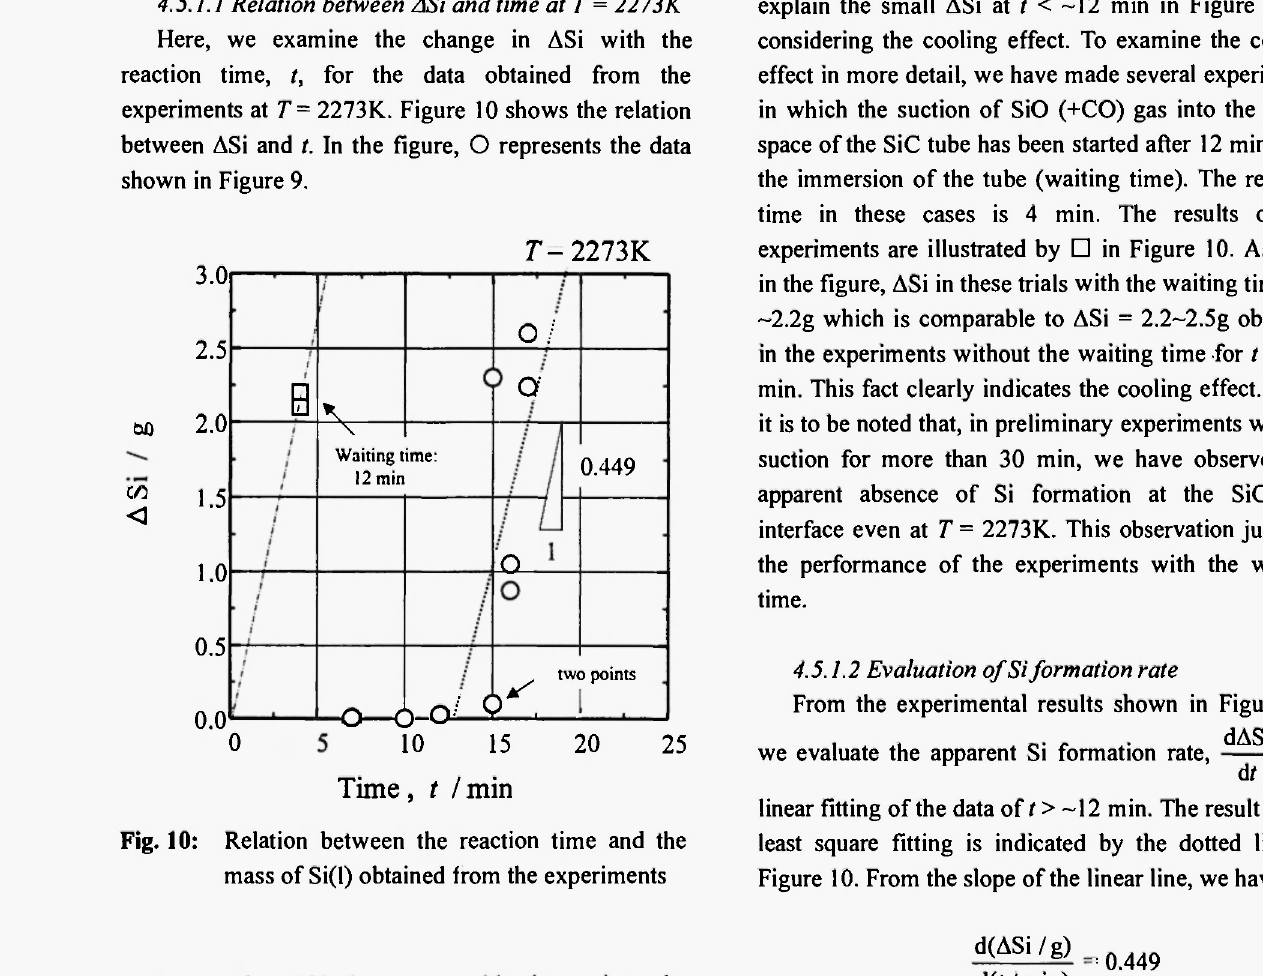
Fig. 10: Relation between the reaction time and the mass of Si(l) obtained from the